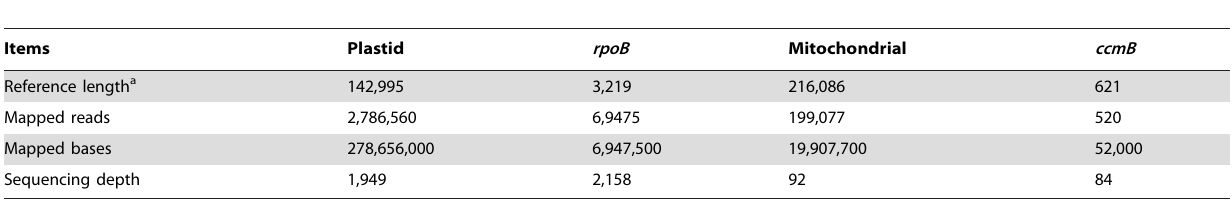
Table 4. Summary of sequence alignments and sequencing depths.